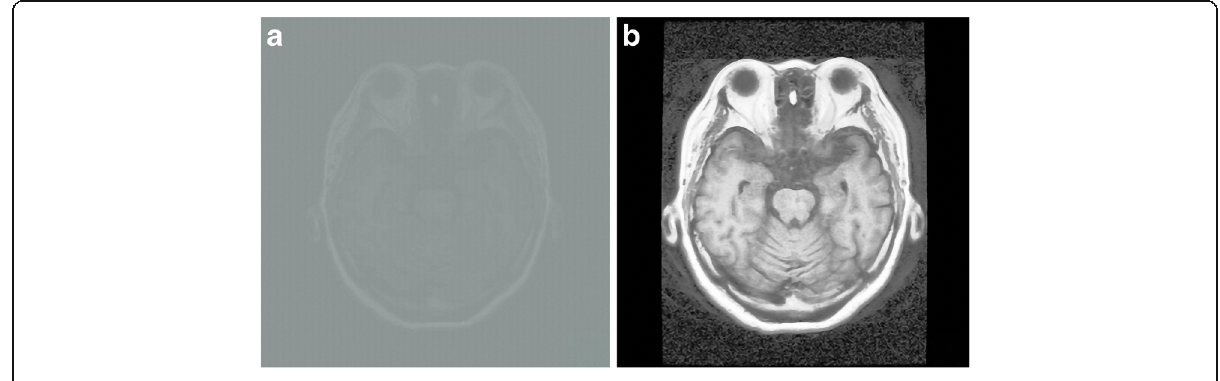
Fig. 6 The result image of gray scale mapping and